Question: Summarize what this figure shows in one sentence.
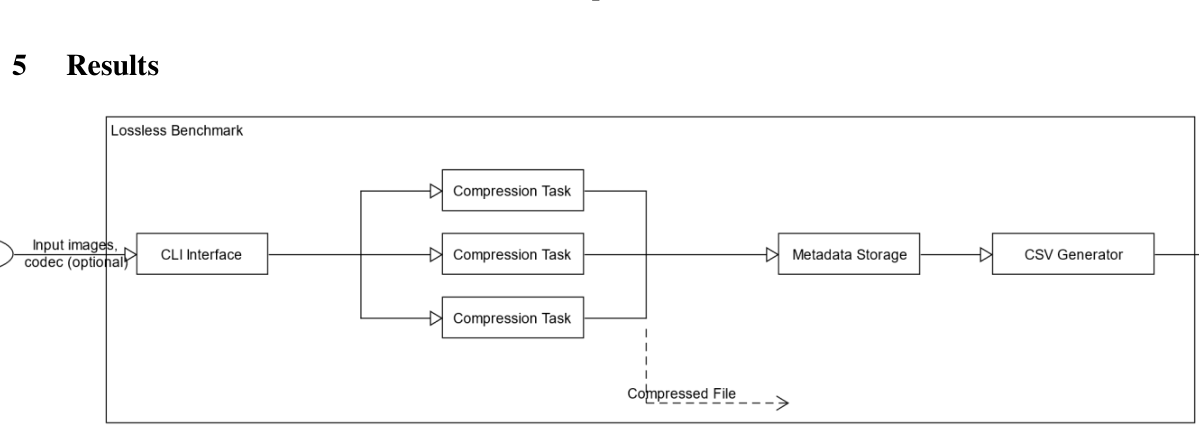
Answer: Contextual diagram of the Lossless Benchmark application